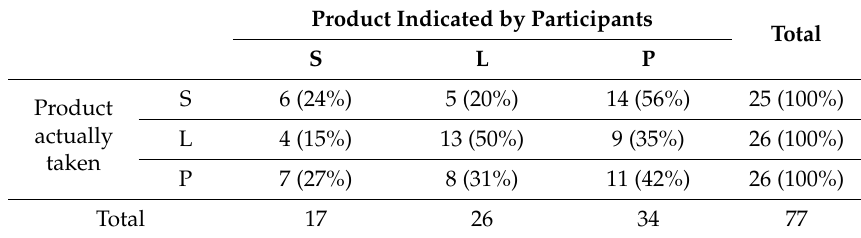
Table 3. Evaluation of the tested product by participants: At the study completion, the participants were asked a question “which product, in your opinion, Saccharomyces , Lactobacillus , or placebo, did you take?” The products indicated by them were compared with the actually